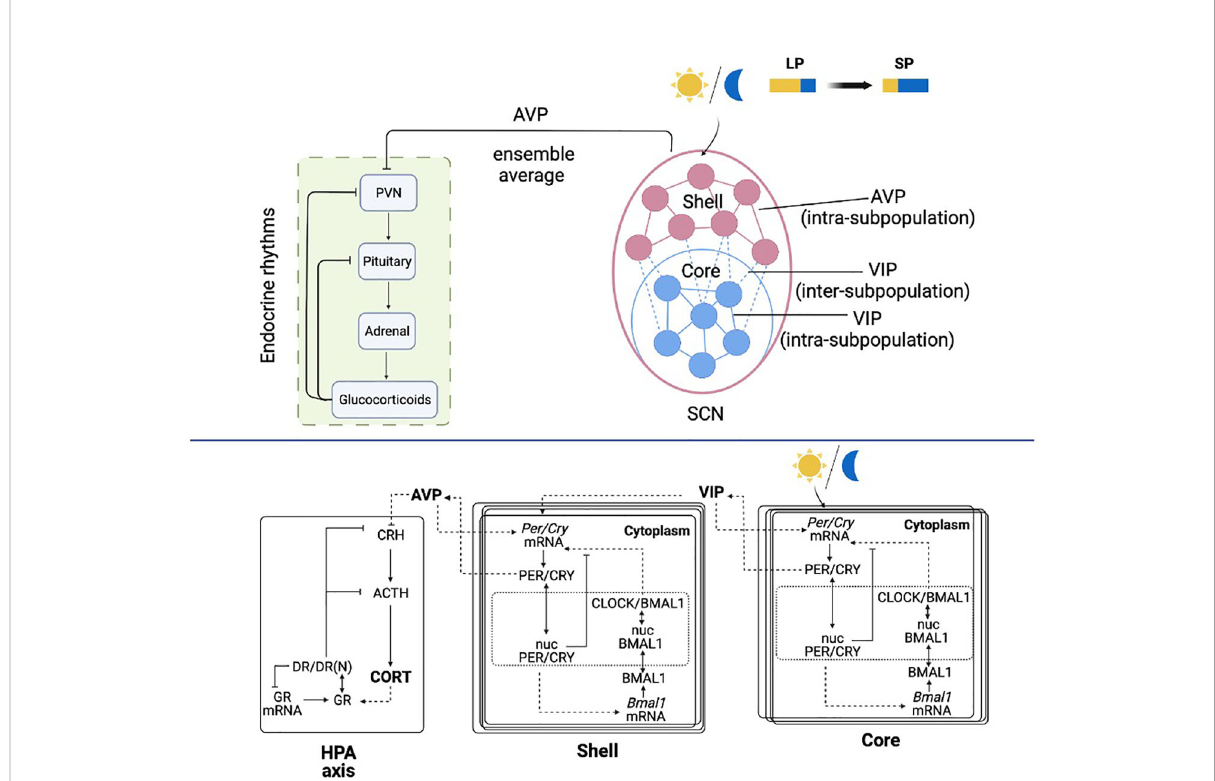
FIGURE 1 Schematic representation of the light entrained multiple-cellular SCN and HPA axis model. The SCN core is entrained to the light/dark cycle, and the shell is entrained by the core through inter-subpopulation VIP signals. The HPA axis is further entrained by the AVP ensemble average signal from the SCN